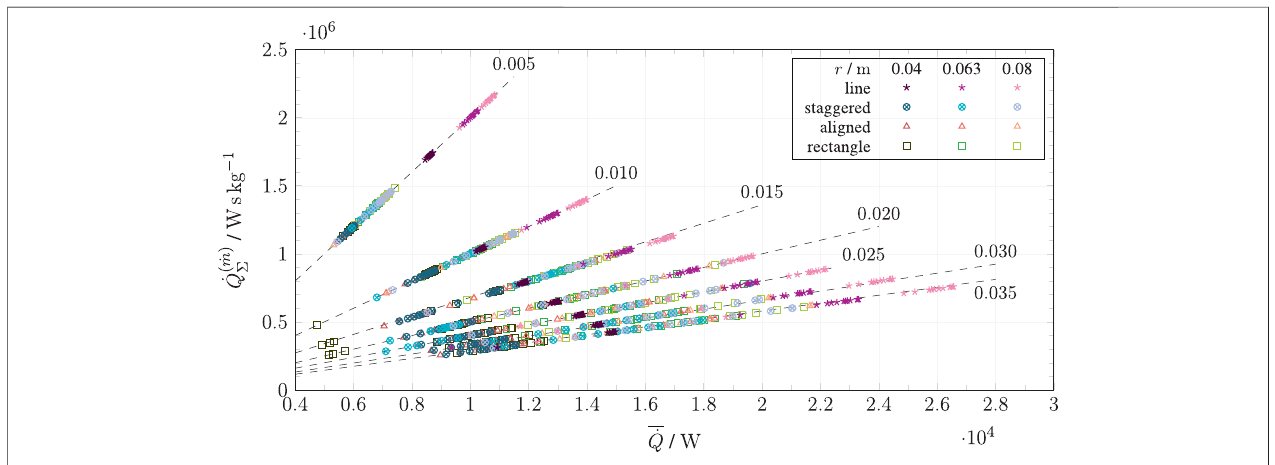
( _ m ) fl owof fl uegasinrelationtothemeanheat fl uxpertube _ Q .Thedashedlineswithlabelsindicatecon fi gurations FIGURE14| Totalheat fl ux _ Q Σ scaledbythemass with equal fl ue gas in fl ow _ m / t per tube in kg/s/tube. The symbol (and its color family) indicates the con fi guration of the data point. Shades of the respective color indicate the inner tube radius r .